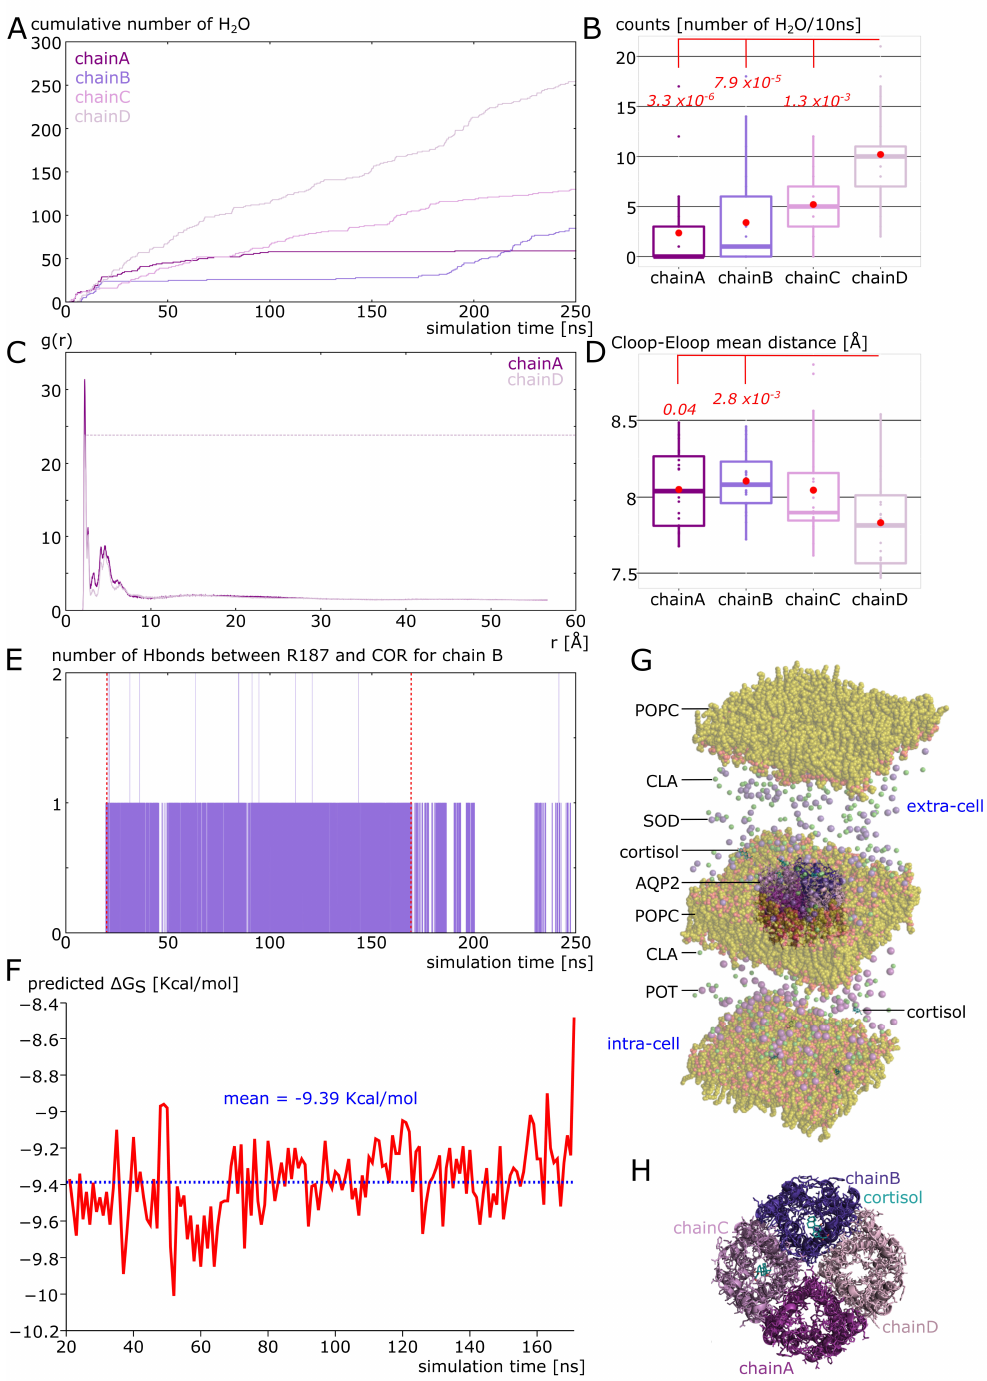
Figure 7. Spontaneous interaction of cortisol with AQP2 extra-cellular surface. ( A ) Cumulative number of water molecules crossing the whole transmembrane section in the pore of chain A, B, C or D along simulation time. ( B ) Comparison of the number of water molecules crossing the conducting pore between the four chains of AQP2. The significant differences with chain D-associated p values are indicated in red and are issued from a Bonferroni post hoc correction after Wilcoxon test. ( C ) Radial distribution function of sodium ions with the extra-cellular surface carboxylates (Glu106, Asp111, Asp115, Asp199 and Asp200) of chain A or chain D as a reference. ( D ) C-loop ( α carbons of residues Lys197, Phe198 and Asp199)—Eloop (Ala117, Val118 and Asn119) mean distance. The significant differences with chain D-associated p values are indicated in red and are issued